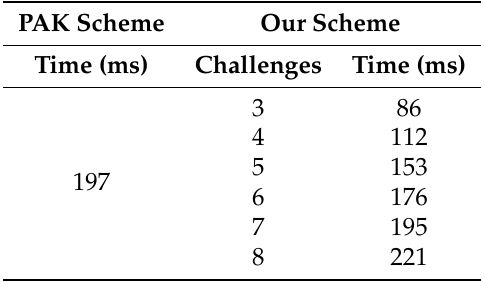
Table 3. Password authenticated key (PAK) scheme vs. the proposed